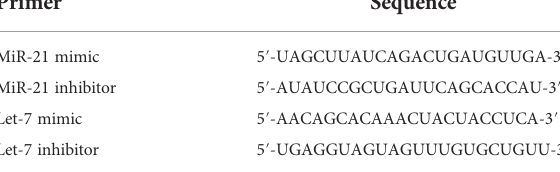
TABLE 3 Sequences of miRNA mimics and miRNA